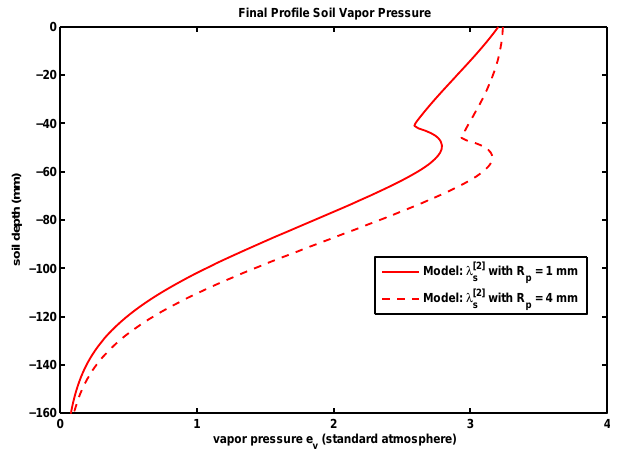
Figure 8. Final modeled profile of vapor pressure at the end of the 90min model simulation. The solid line is the model simulation with R p = 1mm and the dotted line corresponds to the simulation with R p = 4mm. In both cases the maximum vapor pressure occurs at the soil surface and/or near the level of the maximum S v . For these two scenarios the maximum vapor pressure is about 3.2 times the pressure of 1 standard atmosphere (i.e., P ST = 101 .